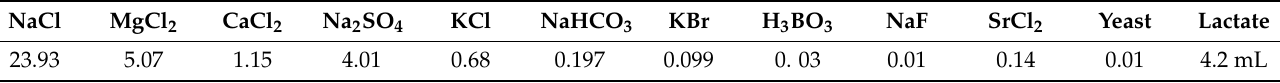
Table 3. Chemical concentration (g/L) in the artificial